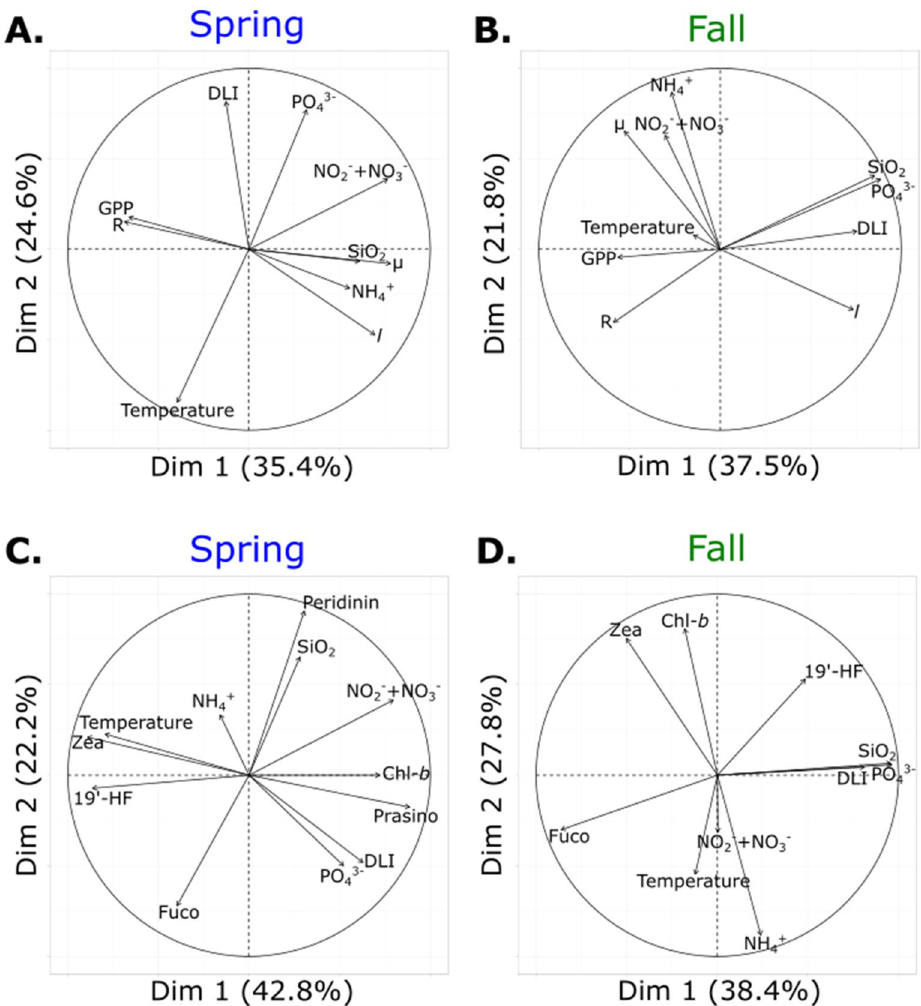
Figure 5. Principal component analyses (PCA) of logarithm response ratio (LRR) of plankton processes ( A , B ) and pigment concentrations ( C , D ) with environmental parameters for the spring ( A , C ) and fall ( B , D ) experiments. GPP: Gross Primary Production, R: Respiration, µ: Phytoplankton growth rate, l : Phytoplankton loss rate, Chl- b : Chlorophyll- b , 19 ′ -HF: 19 ′ -Hexanoyloxyfucoxanthin, Fuco: Fucoxanthin, Prasino: Prasinoxanthin, Zea: Zeaxanthin, DLI: Daily Light